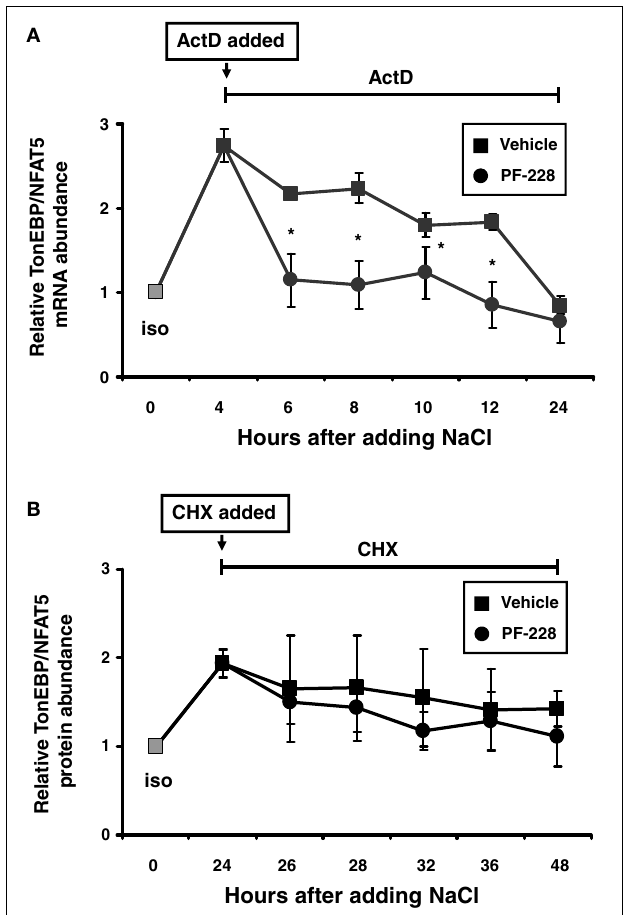
FIGURE 8 | Effect of FAK inhibition on TonEBP/NFAT5 mRNA and protein half-life. (A) HEK293 cells remained in isotonic medium (300mosm/kg H 2 O) or were incubated in hypertonic medium (500mosm/kg H 2 O by NaCl addition) for 4h. Subsequently, actinomycin D (5 μ g/ml) and PF-228 (10 μ M) or vehicle ethanol was added and TonEBP/NFAT5 mRNA abundance was determined at the indicated time points by qRT-PCR. (B) The cells remained in isotonic medium or were incubated in hypertonic medium for 24h prior to the addition of cycloheximide (5 μ M) and PF-228 (10 μ M) or vehicle ethanol. Thereafter, TonEBP/NFAT5 protein abundance was determined at the indicated time points by Western blot analysis. The data are means ± s.e.m. for n = 4 per time point. ∗ p < 0 . 05 for NaCl + vehicle vs. NaCl + PF-228.